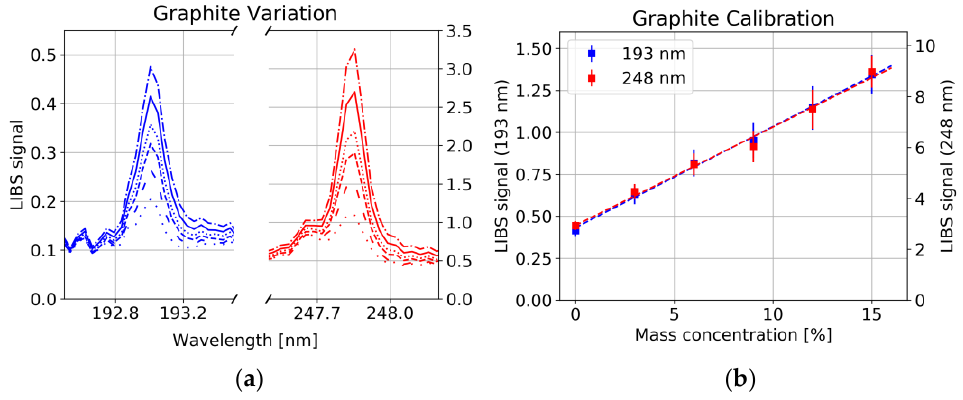
Figure 8. ( a ) Carbon lines (std normalized) for different concentrations of graphite/carbon black (NMC111, 6 mJ) and 8% binder, each spectrum is the average of 625 single measurements. ( b ) Calibration curves for graphite/carbon black content error bars from 25 samples (25 spectra averaged for each sample).